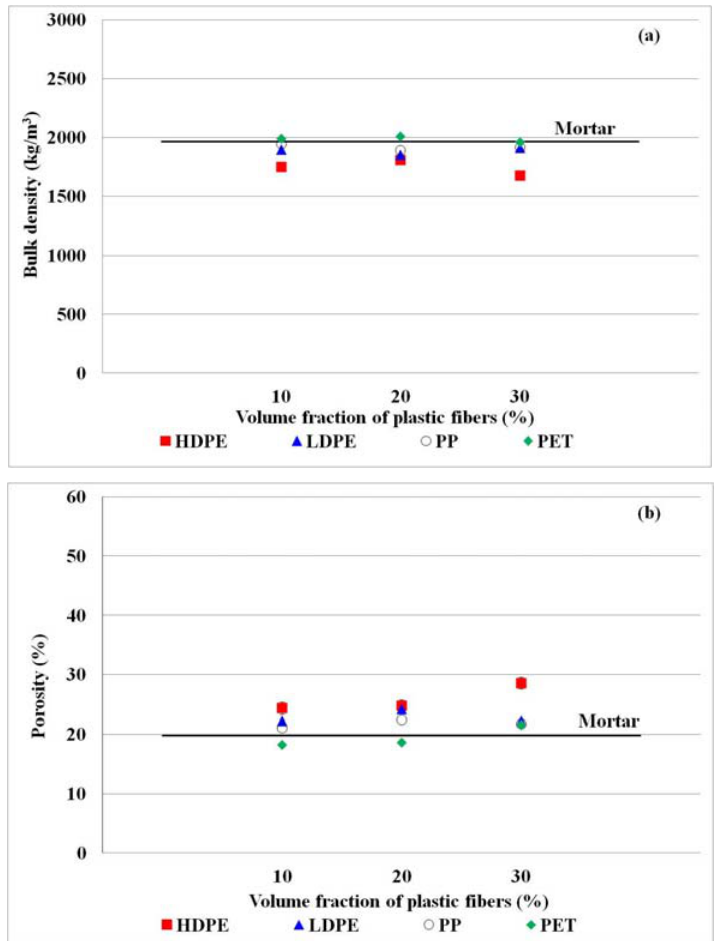
Figure 5. Relationship between volume fraction of plastic fibers and ( a ) bulk density and ( b ) porosity of produced concrete. The bulk density and porosity of mortar (control sample) are in the solid line.